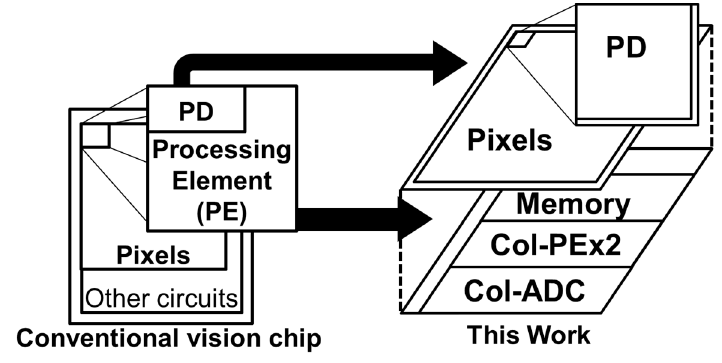
Figure 1. 3D stack vision chip.